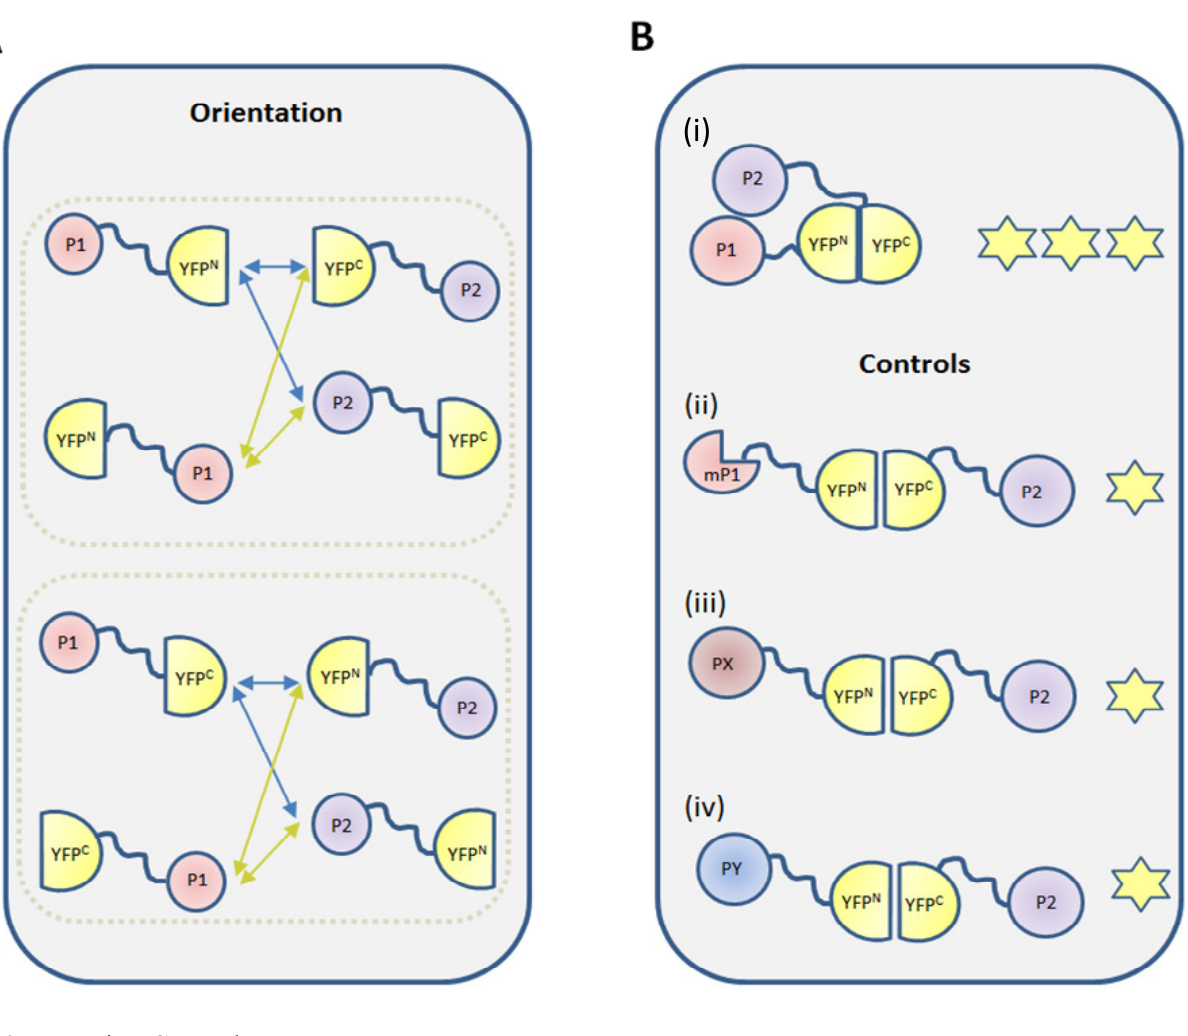
Figure 4. Two key elements of a BiFC experiment: fusion orientation and